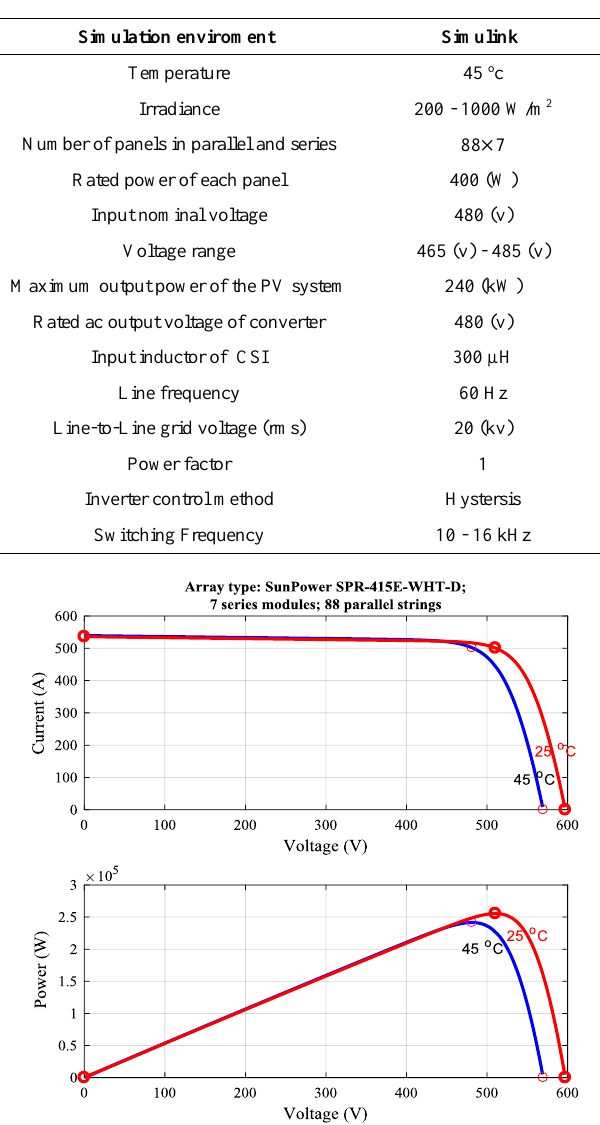
Table 2 . Simulation parameters of the multistage converter with current source inverter